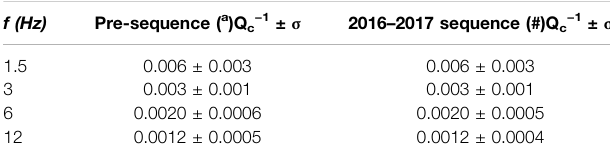
TABLE1| Q c − 1 forthetwomaindatasets,withtheirassociatedstandarddeviation σ , was obtained from linear regression ( Figure 5 ) at each frequency band. a and # are the dependence of Q c − 1 vs frequency for the pre-sequence and 2016 – 2017 sequence, respectively.